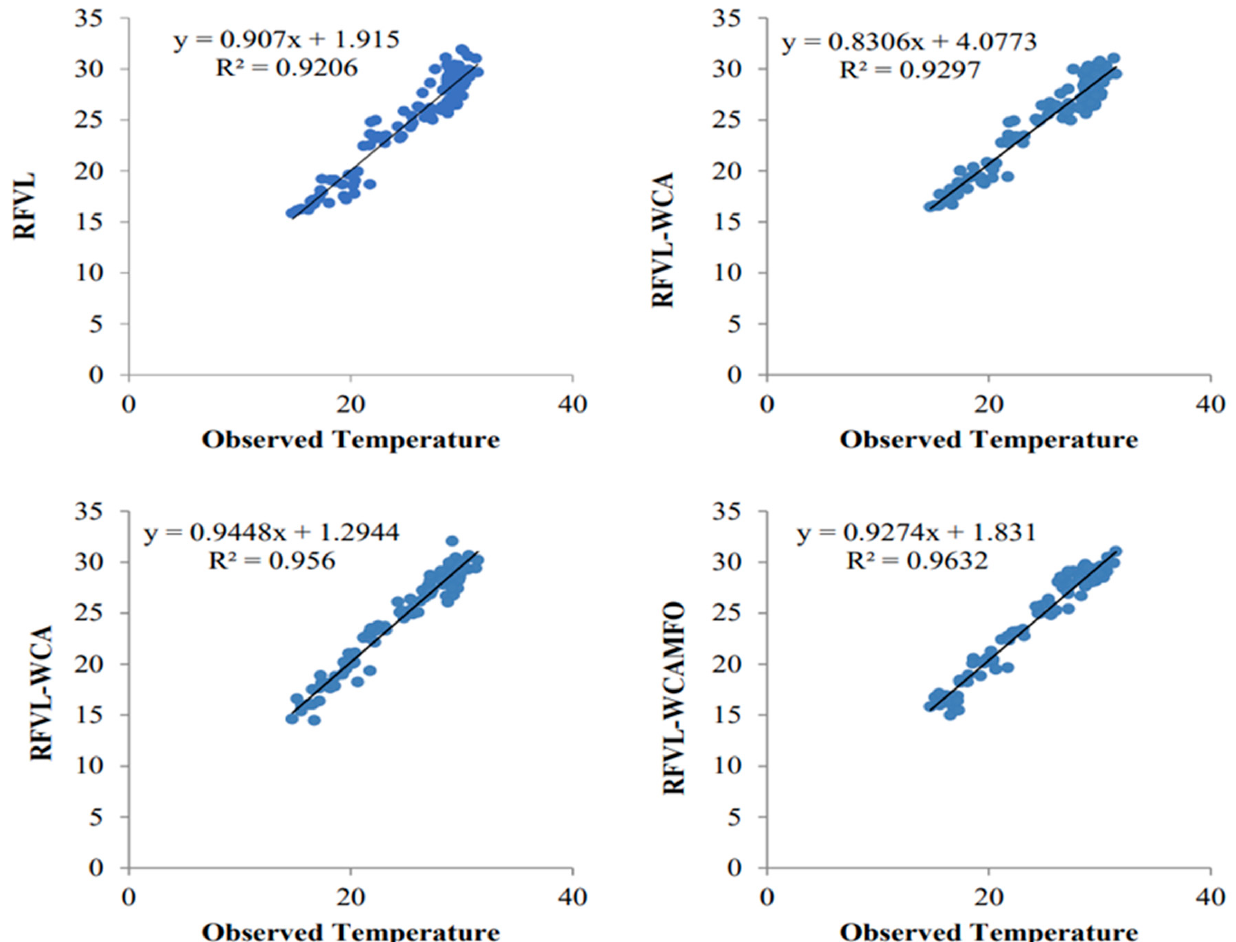
Figure 4. Scatterplots of the observed and predicted Temperature by different RVFL-based models in the test period using best input combination for monthly time scale.